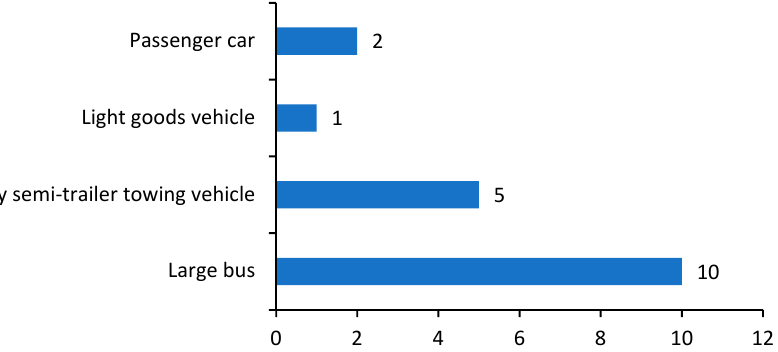
Figure 2. Number of different kinds of commercial vehicles involved in the crashes. Note: The vehicles in China are classified by the standard according to the purpose, wheel base, bodywork length, load, etc.